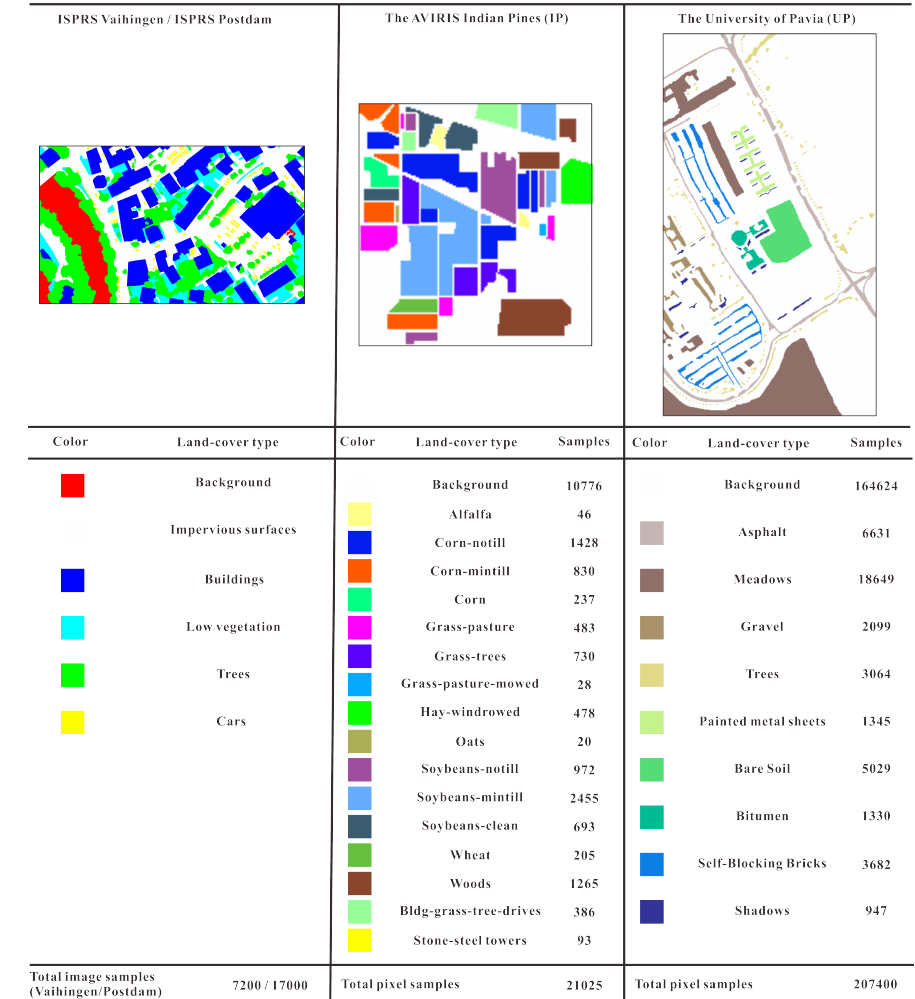
Figure 7. Ground-truth images of different datasets and the number of image samples for high-resolution datasets (Vaihingen and Potsdam) and pixel samples for hyperspectral datasets (the IP and UP